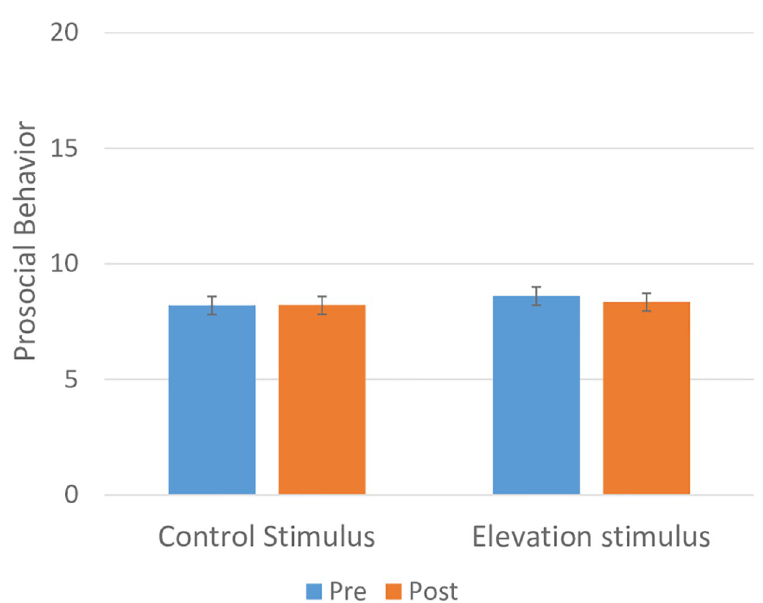
Fig 4. Testing for pre-stimulus to post-stimulus change in prosocial behavior among those receiving the moral elevation video stimulus (n = 237) vs. those receiving the Control (nature) video stimulus (n = 248) after adjusting for participant characteristics using a mixed model ANCOVA). A Group by Run interaction was non-significant ( F 1,478 = 2.40; p = 0.12). Adjusted estimates of prosocial behavior are shown with standard